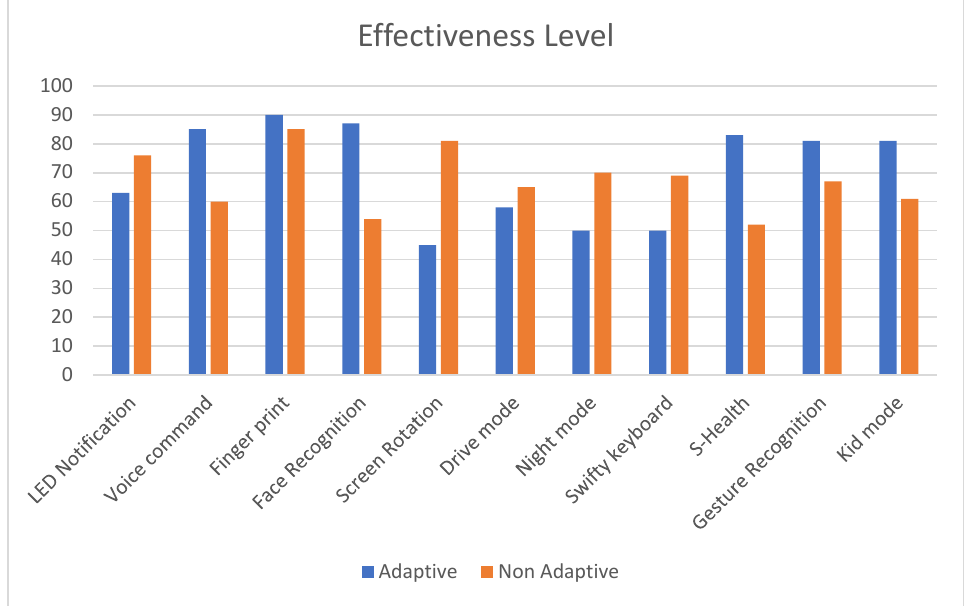
Figure 1. Effectiveness levels for adaptive and non ‐ adaptive features.